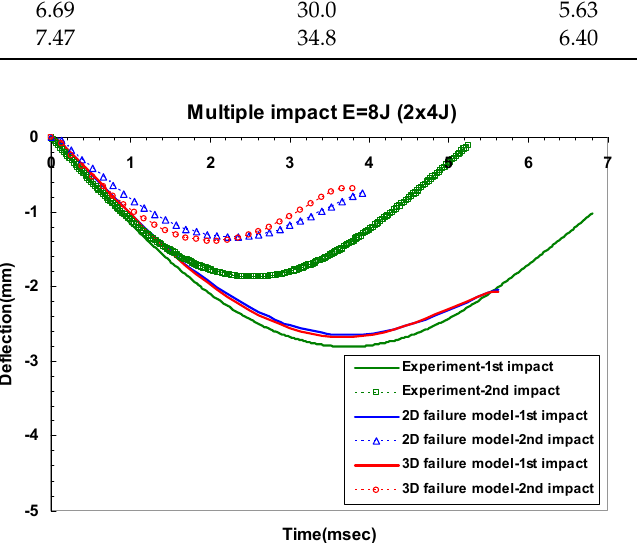
Figure 18. Difference between the predicted and measured central deflection for GLARE 5-2/1 under impact energy of 8 J.